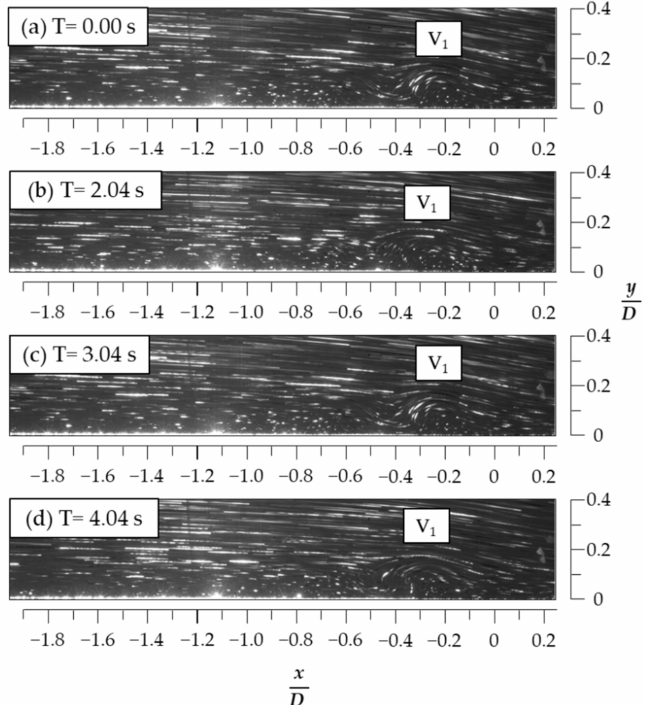
Figure 7. Time-series flow visualization of the cross-section of HSV’s leg portion in the z = 0.8 cm plane when H / D = 0. The HSV structure (labeled V1) near x / D = − 0.23 was not as clear as shown in the other two